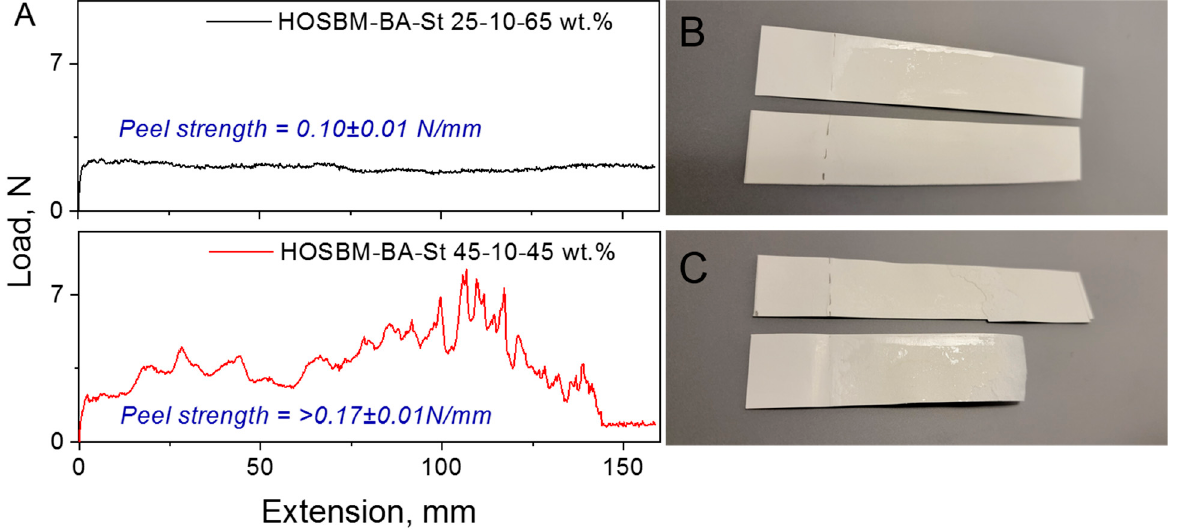
Figure 6. Peel strength of HOSBM-BA-St 25–10–65 wt. % and 45–10–45 wt. % latexes copolymers on paperboard (coated to uncoated) substrates ( A ) and substrate samples after peel strength